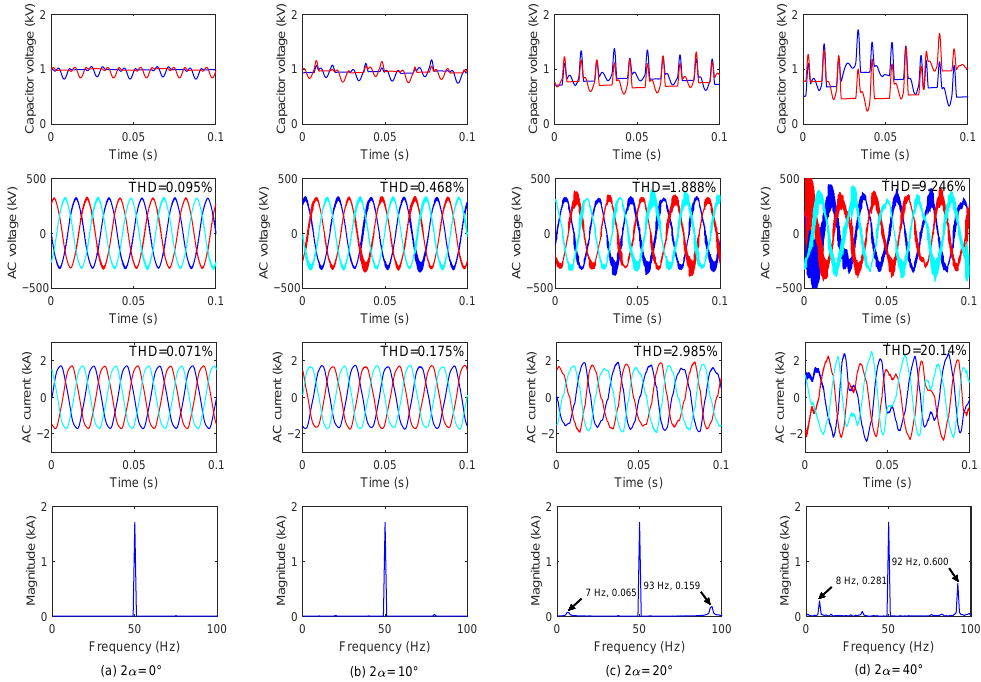
Figure 9. Simulation results of the AAC system with different overlap periods: ( a ) 2 α = 0 ◦ ;